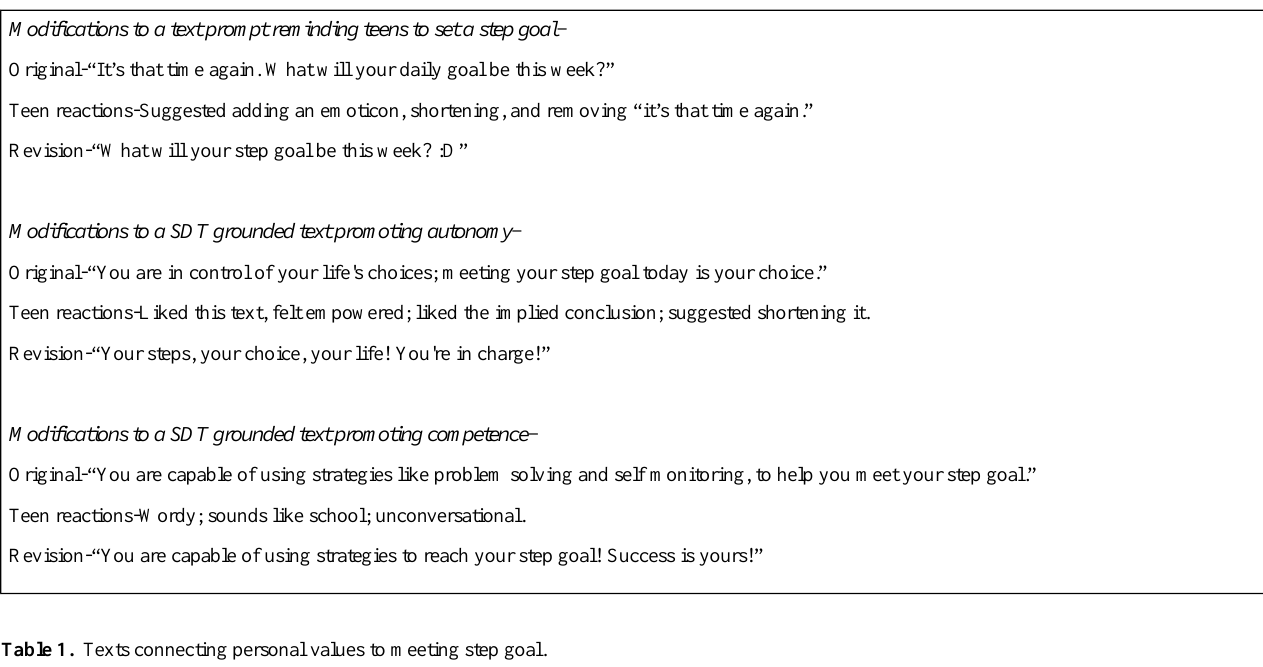
Text messagePersonal